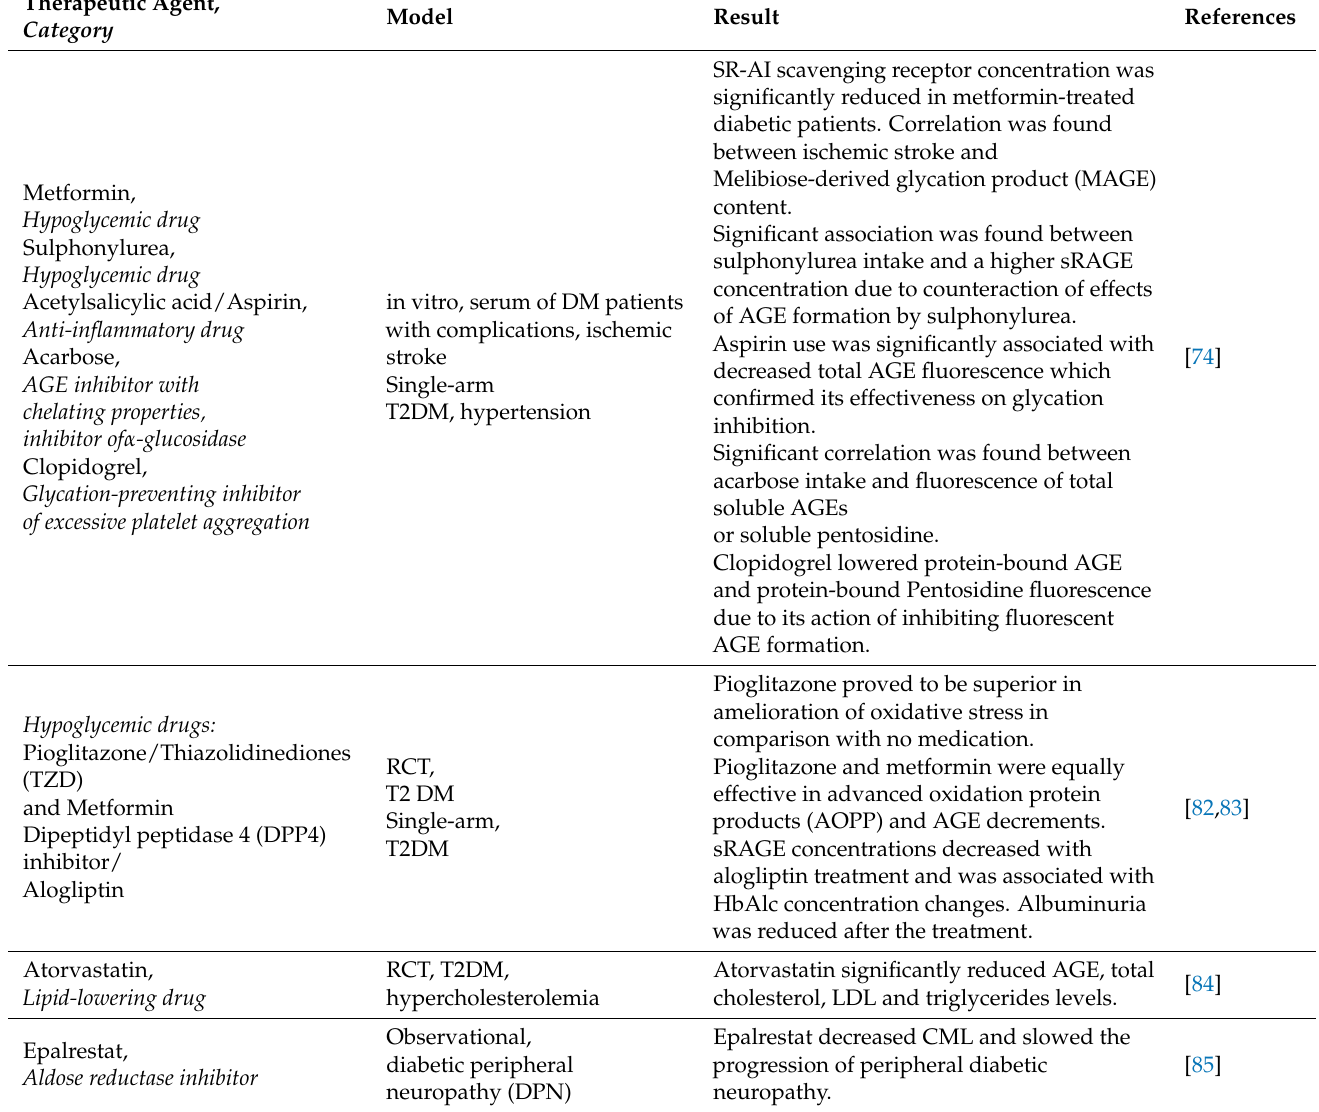
Table 3. Experimental and clinical findings on therapeutic drugs against AGE–RAGE axis in diabetic cardio-cerebrovascular